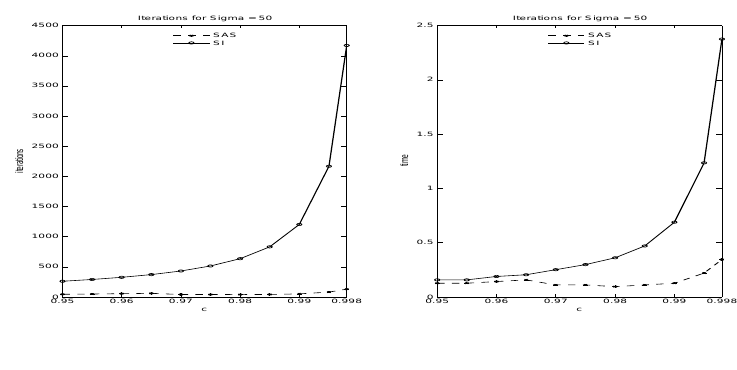
Figure 1. Comparison at fixed σ = 50 of Source Iteration and SAS in slab geometry for values of c close to 1 ( ǫ = 1 E − 06 ): (left) Number of iterations; (right) CPU